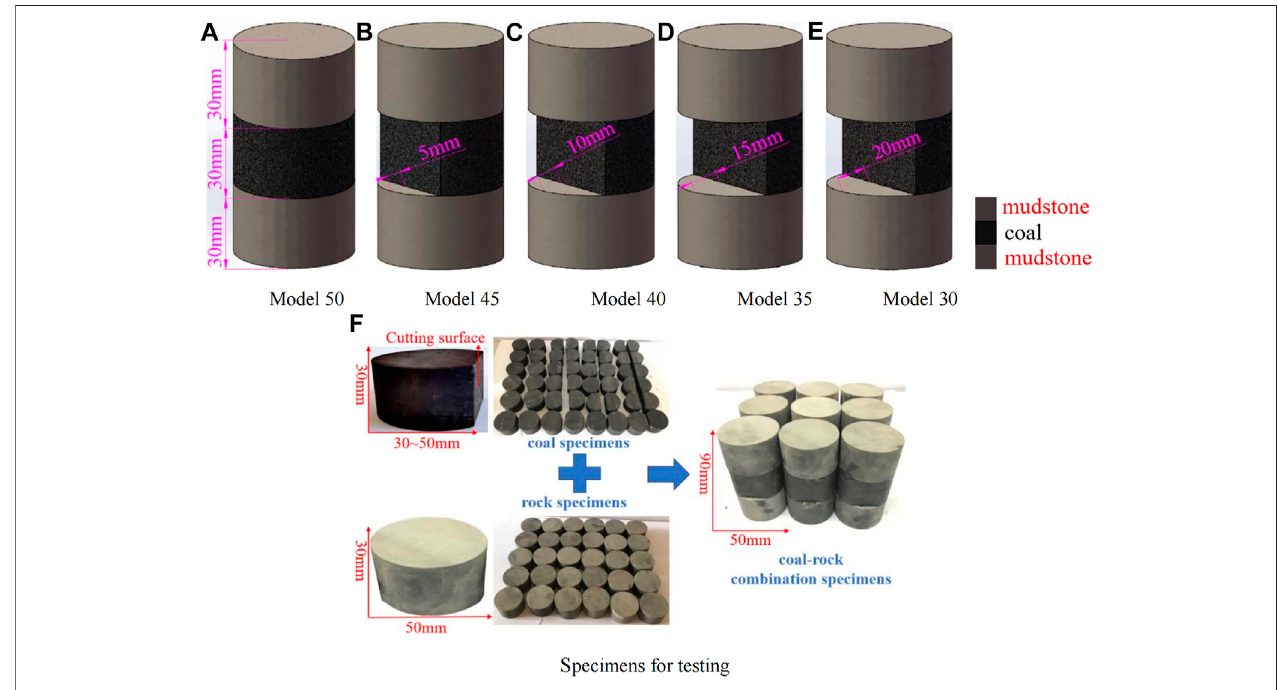
FIGURE 4 | (A – E) Specimen models; (F) Specimens for